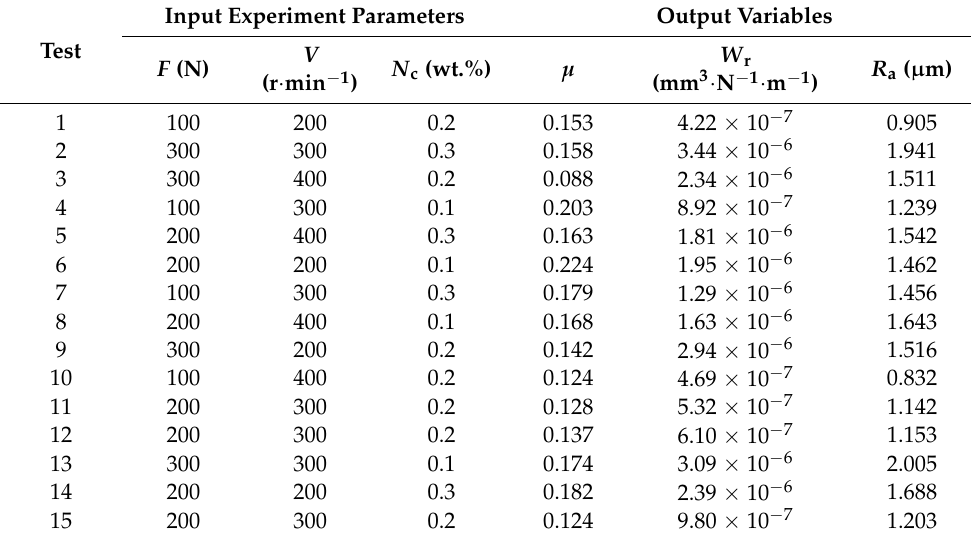
Table 5. Input experiment parameters and response variables.